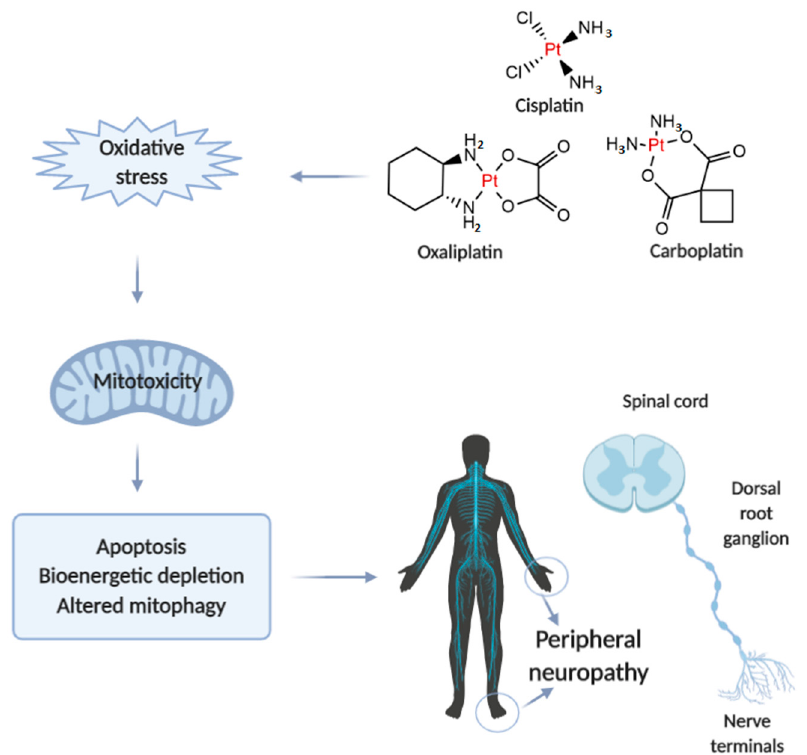
Figure 1. Illustrative presentation of the development of platinum-based drug-induced peripheral neuropathy. Created in BioRender.com.